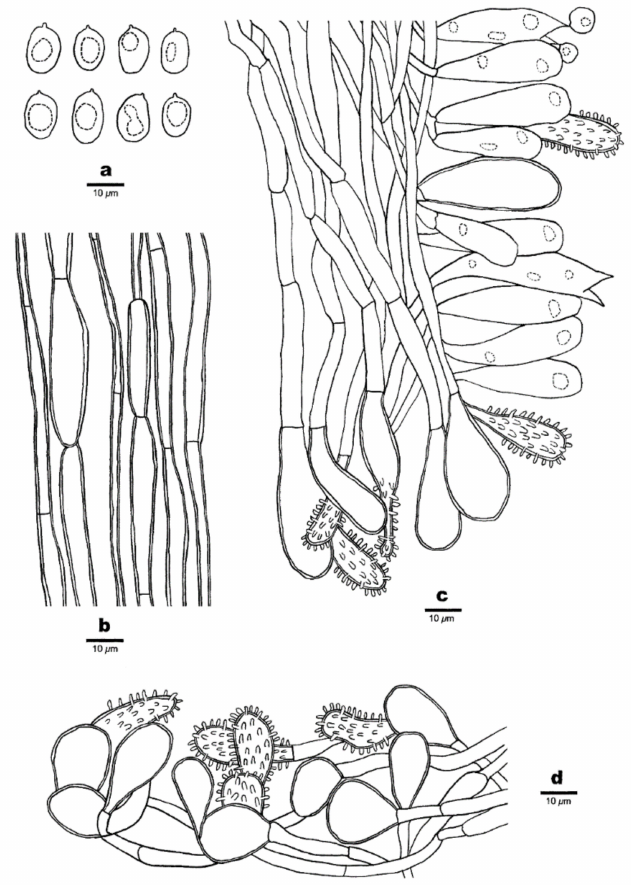
Figure 7. Microscopic structures of Favolaschia brevistipitata (Dai 19780, holotype). ( a ) Basidiospores. ( b ) Medullary hyphae of the stipe. ( c ) Hyphae at edge of pores showing gloeocystidia, acanthocystida, basidia and basidioles. ( d ) Hyphae of pileus cortex, composed of a hymeniform layer of acanthocysts and